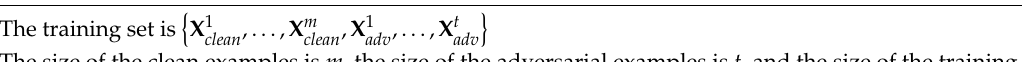
Algorithm 2 The process of adversarial training